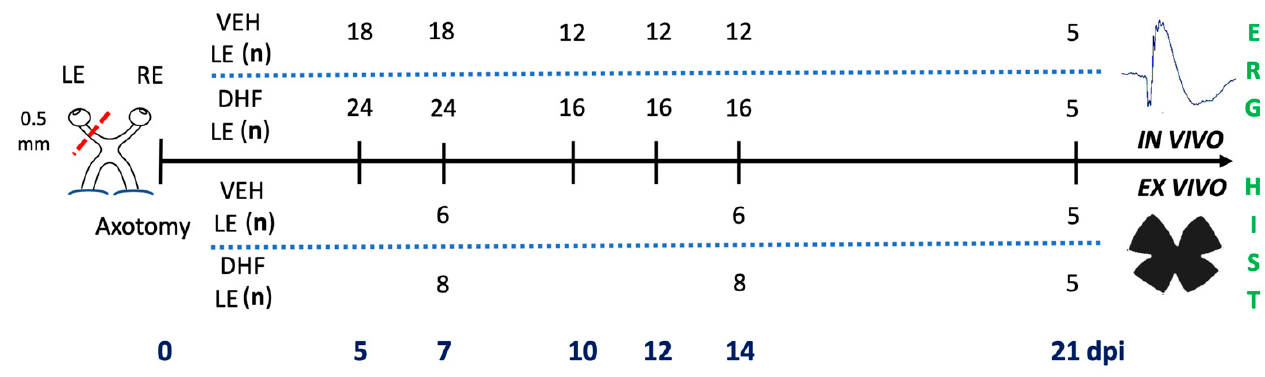
Figure 9. Experimental design: animal groups, timeline, and analyses. Rats received an intraorbital optic nerve section of the left eye on day 0, and were treated daily with intraperitoneal injections of DHF (5 mg/kg) or vehicle (1% DMSO in 0.9% NaCl) starting the day before IONT. In vivo, a longitudinal functional study was performed with full-field electroretinograms at 5, 7, 10, 12, 14 and 21 days post injury (dpi). Ex vivo, retinas were prepared as wholemounts and analyzed with immunohistochemical techniques to assess retinal ganglion cell survival at 7, 14 and 21 dpi.